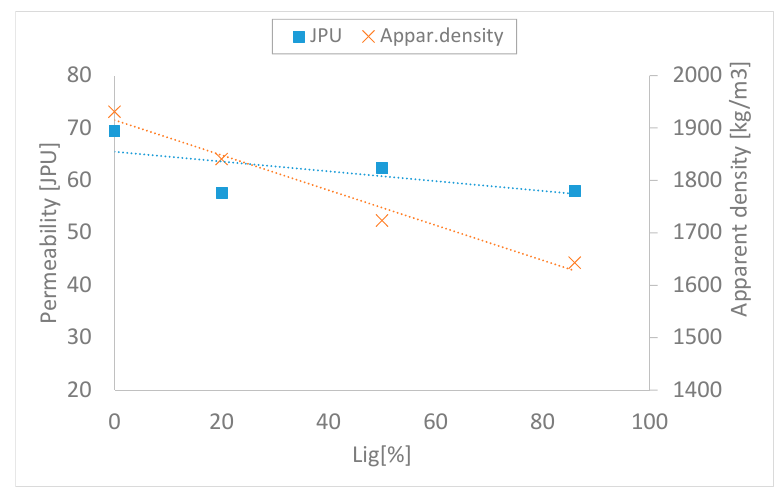
Figure 9. Impact of substitution on both the apparent density of the charge and the permeability.